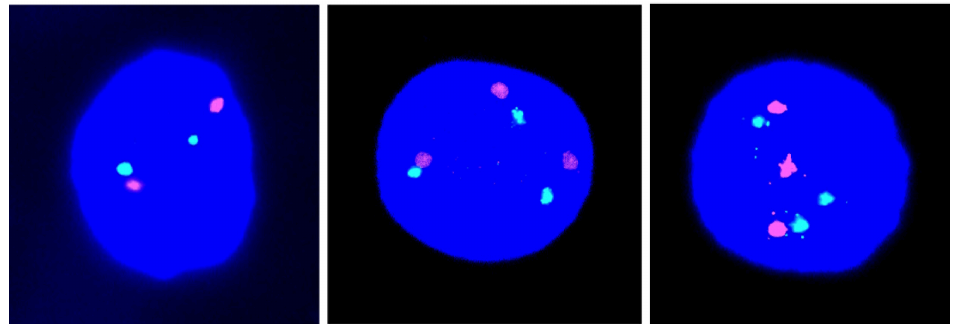
Figure 1. Illustrations of cell nuclei containing a different chromosome 21 copy number: Two red-green signals indicative of disomy 21 (left) and three red-green signals indicative of trisomy 21 (middle and right).